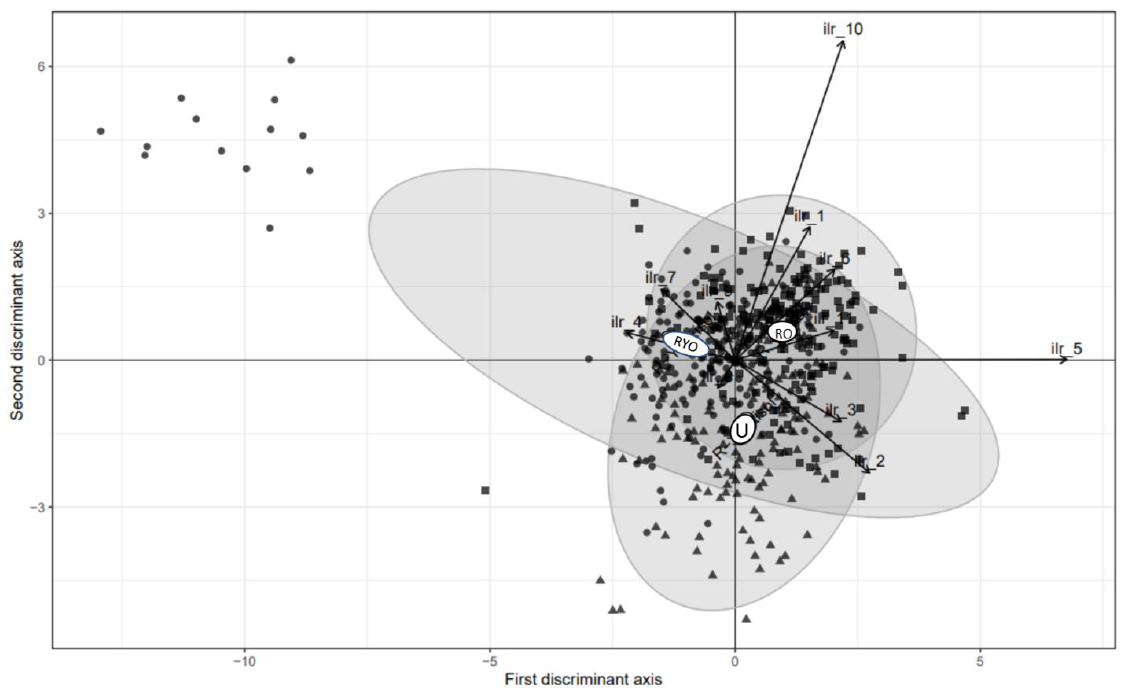
Figure 2. Discriminant analysis of scion ionomes ( upper figure) and soil test results in the 0 – 20 cm and 20 – 40 cm layers of soil classes ( lower figure). P = ‘ Pêra ’ X ‘ Tangerina Sunki ’ (●) ; HAM = ‘ Hamlin ’ X ‘ Citrumelo Swingle ’ ( ▪ ); VAL = ‘Valência’ X ‘ Citrumelo Swingle ’ (+); RYO — Red-Yellow Oxisol ( • ); RO = Red Oxisol ( (cid:4) ); U = Red-Yellow Ultisol ( (cid:78) ); ilr = orthonormal isometric